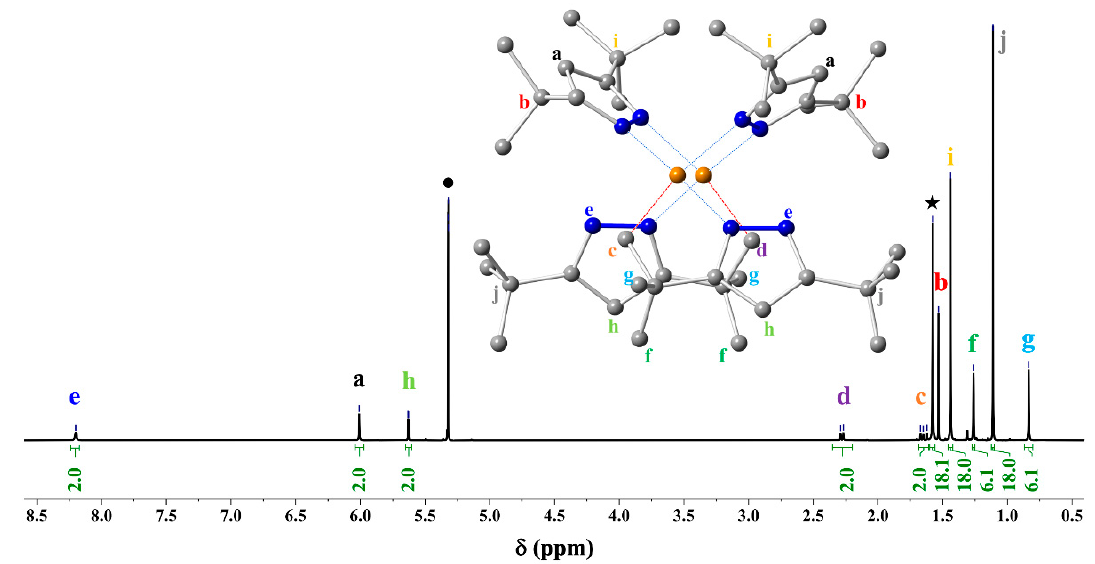
Figure 3. 1 H NMR of 2 in CD 2 Cl 2 at 293 K. Solvent peaks are identified by solid dot (CHDCl 2 ) or star (H 2 O). Peak integrations in green. Protons, except N-H, are omitted for clarity. Inset: Ball-and-stick diagram of 2 with proton labels.